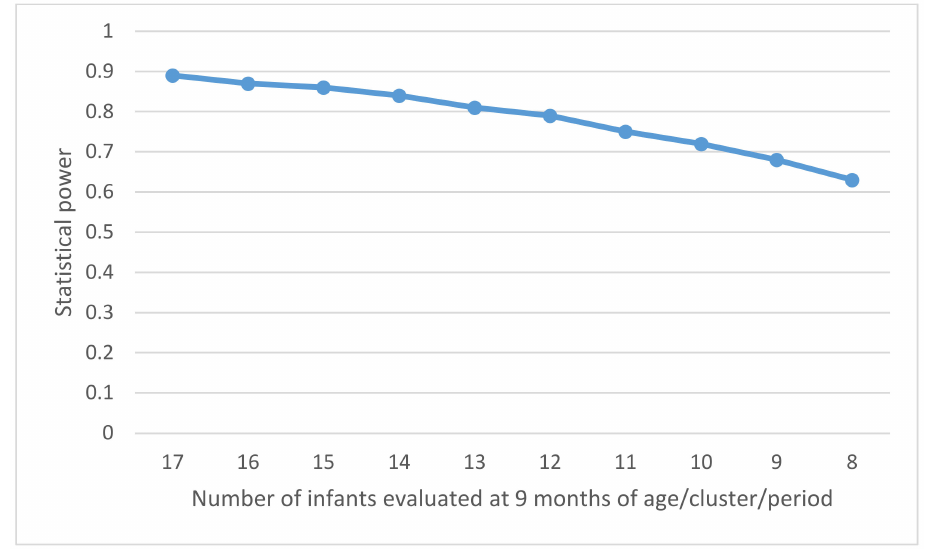
Figure 5. Power of the study according to the number of infants evaluated at the age of 9 months per cluster and per